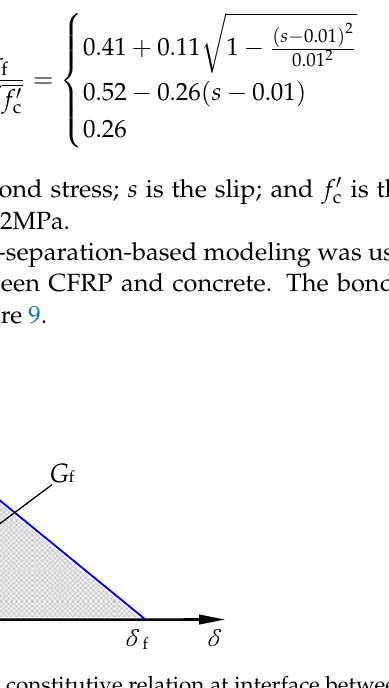
Figure 9. Bond-slip constitutive relation at interface between CFRP and